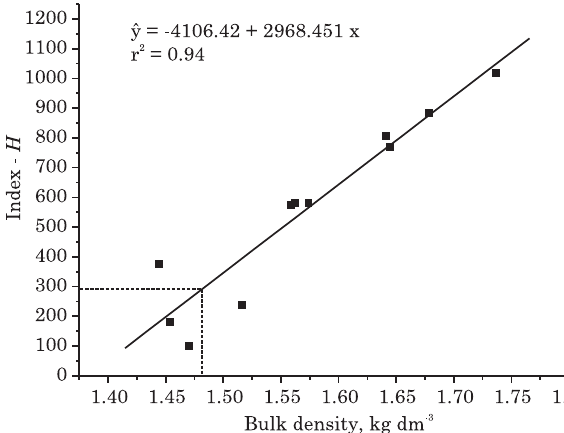
Figure 7. Index H values in function of the soil bulk density for hard-setting soils with sandy clay and sandy clay loam textures. The dashed line shows the value H = 292 and the corresponding value of bulk